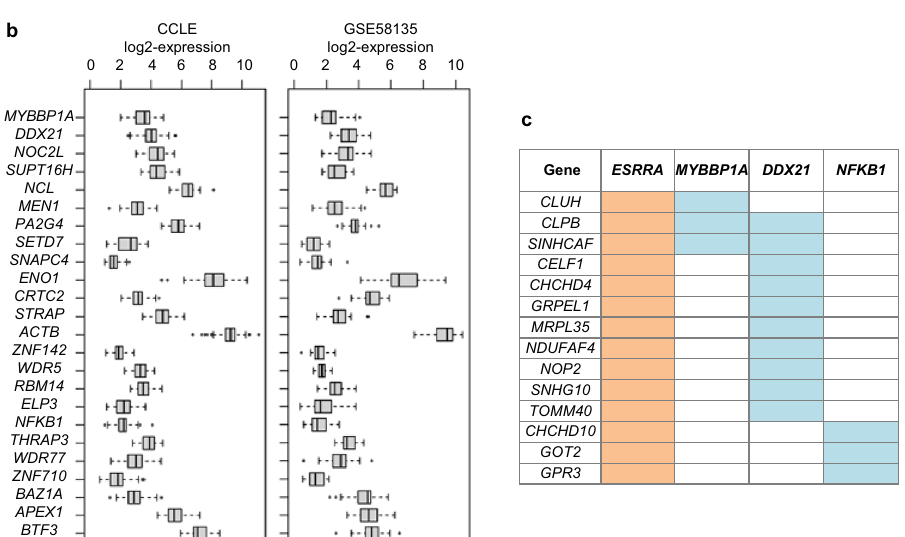
Figure 4. Transcriptional regulators associated with ESRRA in sPLS expression models of ERRα-activated genes. ( a) Venn diagram of TRs with model coefficient > 0 and p -value < 0.05 identified from the ERRα-activated genes with reliable sPLS models in CCLE and GSE58135 datasets. The 24 selected TRs commonly identified in the two datasets are ordered according to the mean proportion of genes (mean gene prop, > 0.2) over the CCLE and the GSE58135 datasets for which the TR has positive coefficient in the 10 model replicates computed with one dataset. HAT: histone acetyltransferase, FACT: facilitates chromatin transcription, HMT: histone methyltransferase, chrom: chromatin, ACF: ATP-dependent chromatin assembly factor, TF: transcription factor. ( b) Expression boxplots for the 24 selected TRs (same order as table above). Expression is upper-quartile normalized by sample and log2-transformed. ( c) Genes including at least one of MYBBP1A, DDX21 or NFKB1 as selected TR in addition to ESRRA in their sPLS